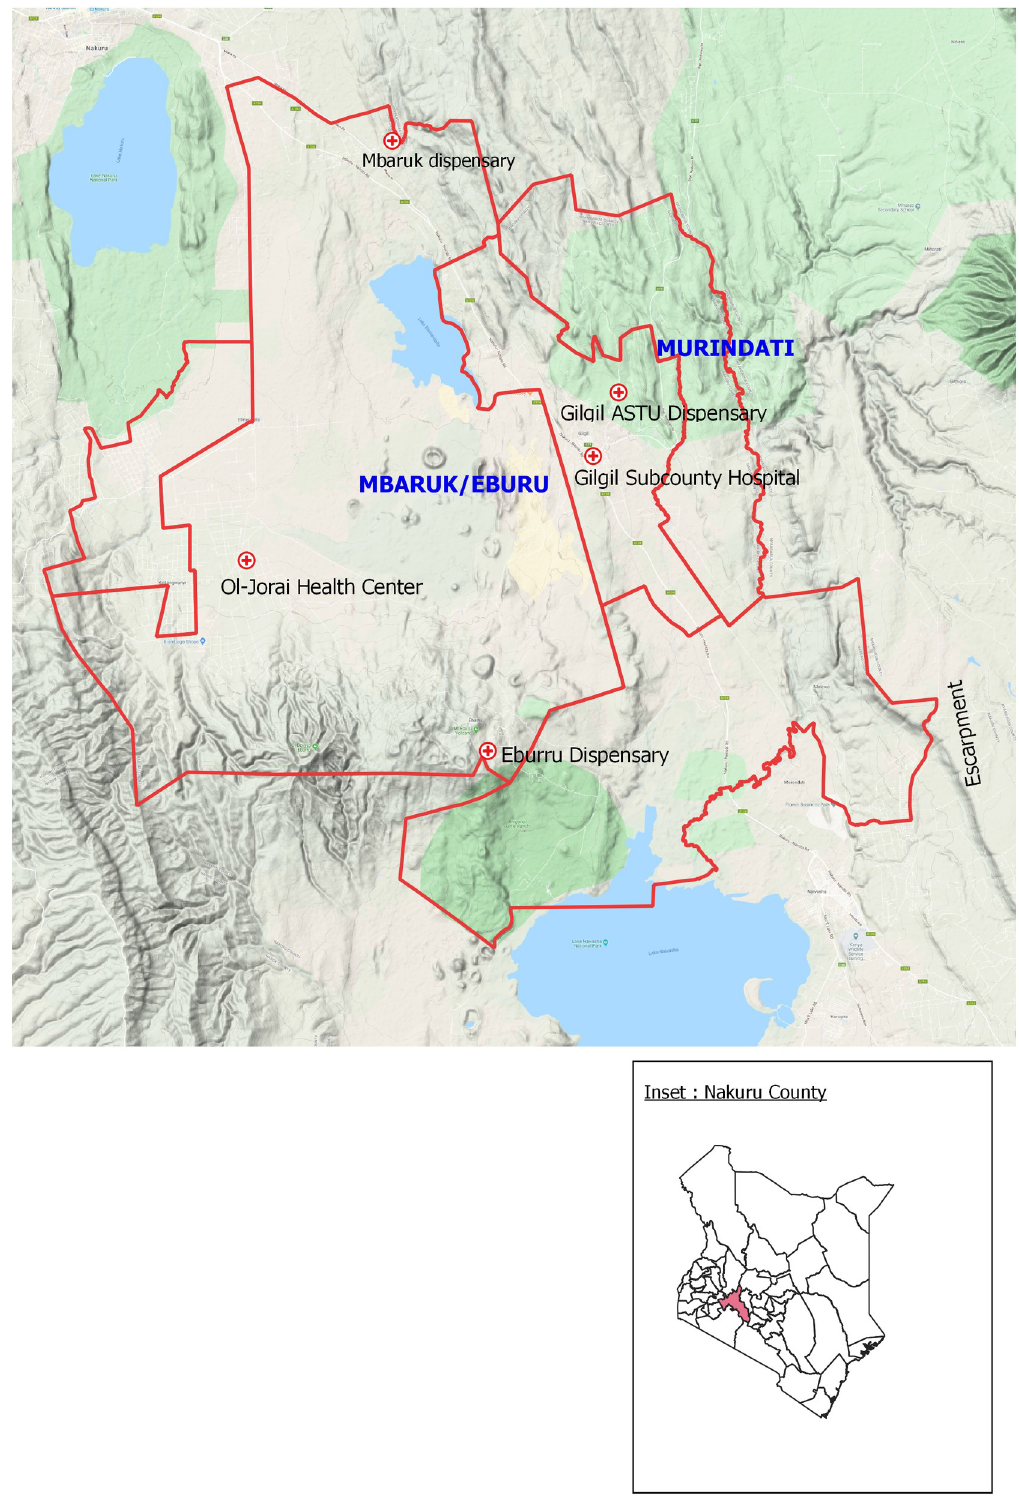
Fig 1. Map of the investigation area, Gilgil, Kenya 2016. This map was drawn on QGIS Version 2.18.15 using mapping resources from International Livestock Research Institute (ILRI) [16,17].